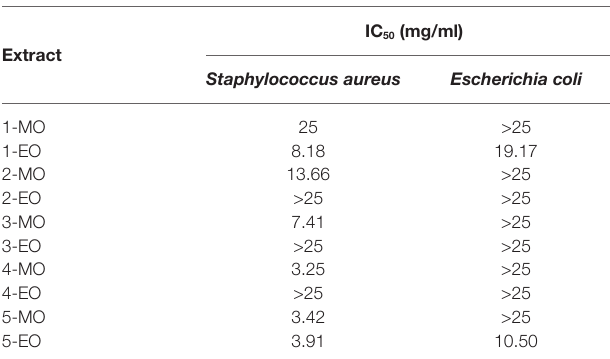
TABLE 2 | IC 50 for mycelial (MO) and extracellular (EO) crude organic extracts obtained from the cultivation of native fungal